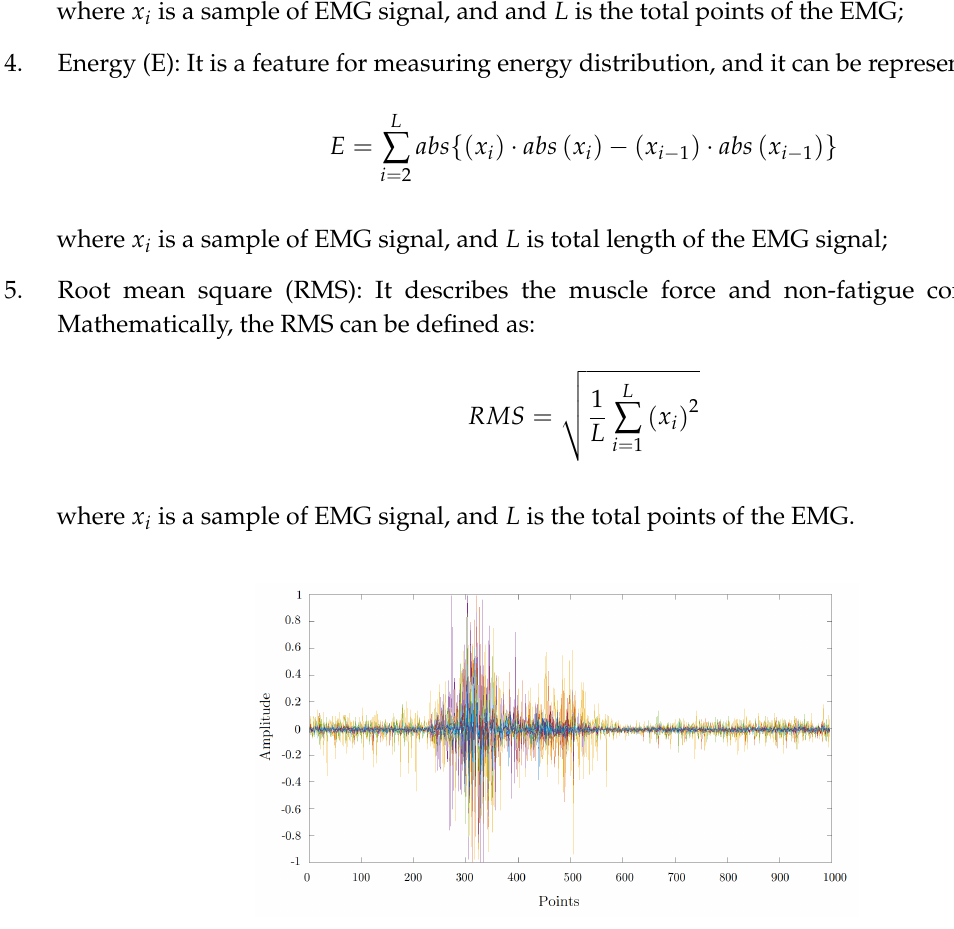
Figure 5. A sample of an electromyography (EMG) signal recorded using the Myo bracelet with the position of the sensors suggested by the Myo manufacturer for the Fist